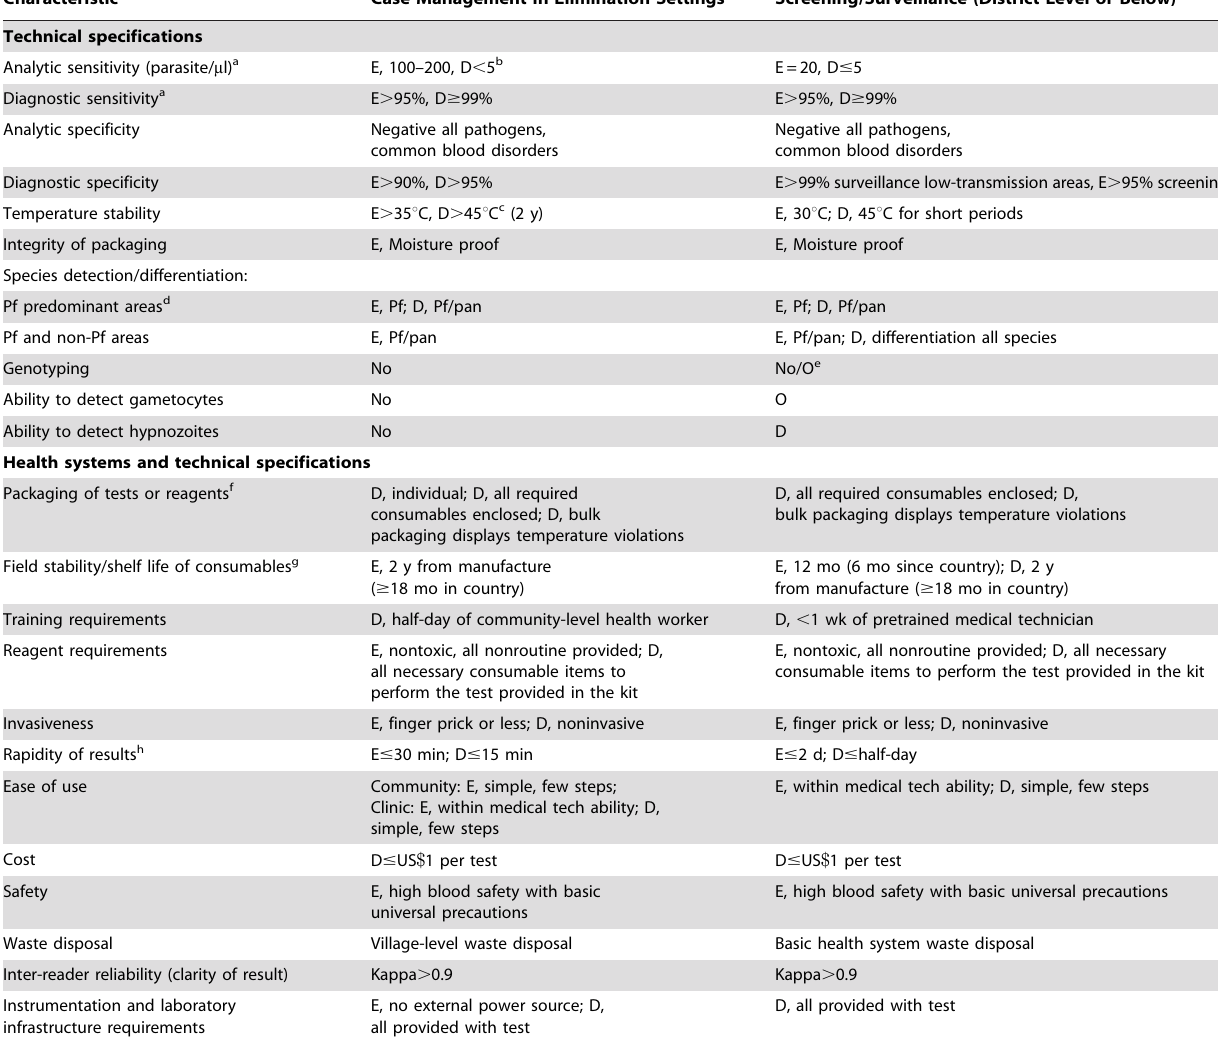
Table 1. Target product profiles for malaria